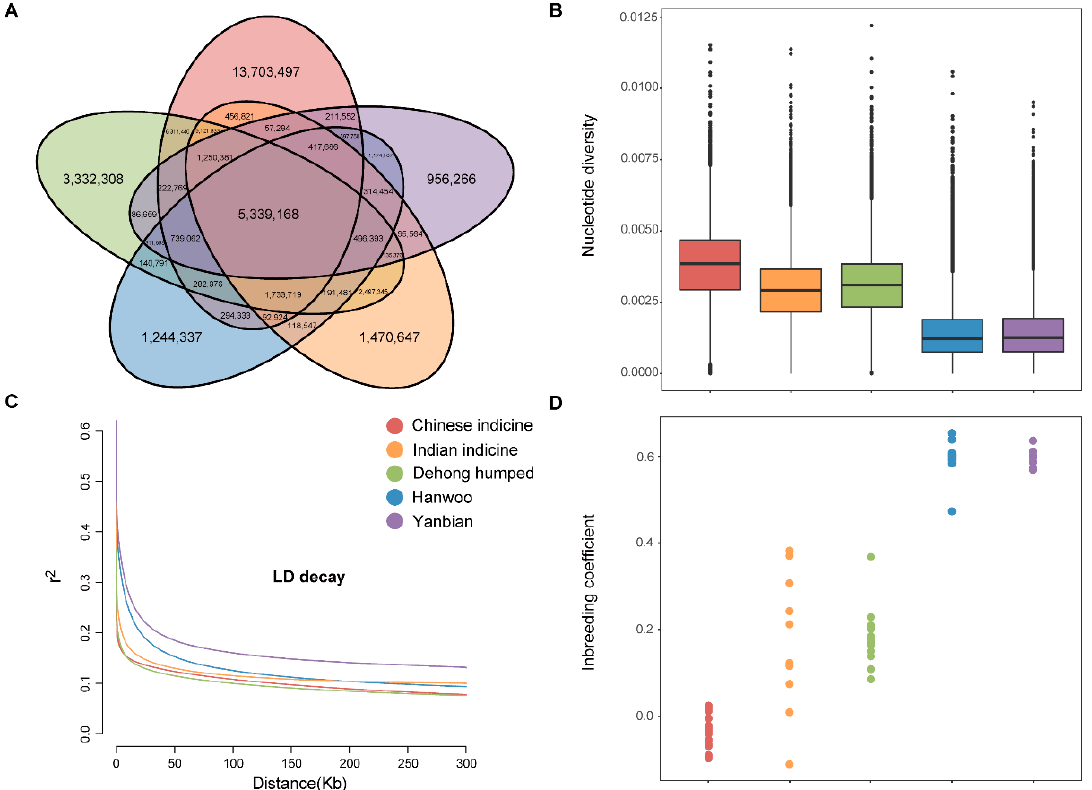
Figure 1. Genetic diversity among 71 samples from 5 populations. ( A ) The numbers of shared SNPs and private SNPs across the five populations by the Venn diagram. ( B ) The nucleotide diversity for each group by box plots. ( C ) Decay of linkage disequilibrium on cattle autosomes estimated from each breed. ( D ) Inbreeding coefficient for each individual.